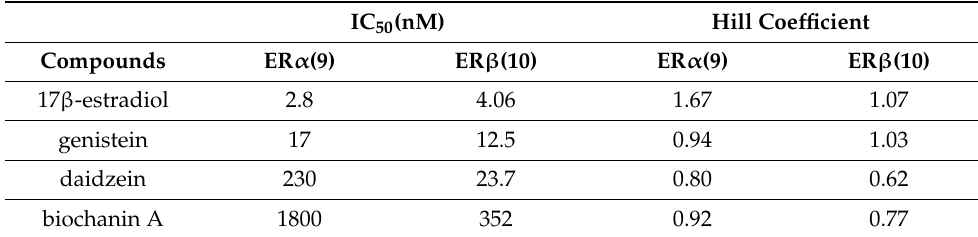
Table 1. Binding parameters of some phytoestrogens to